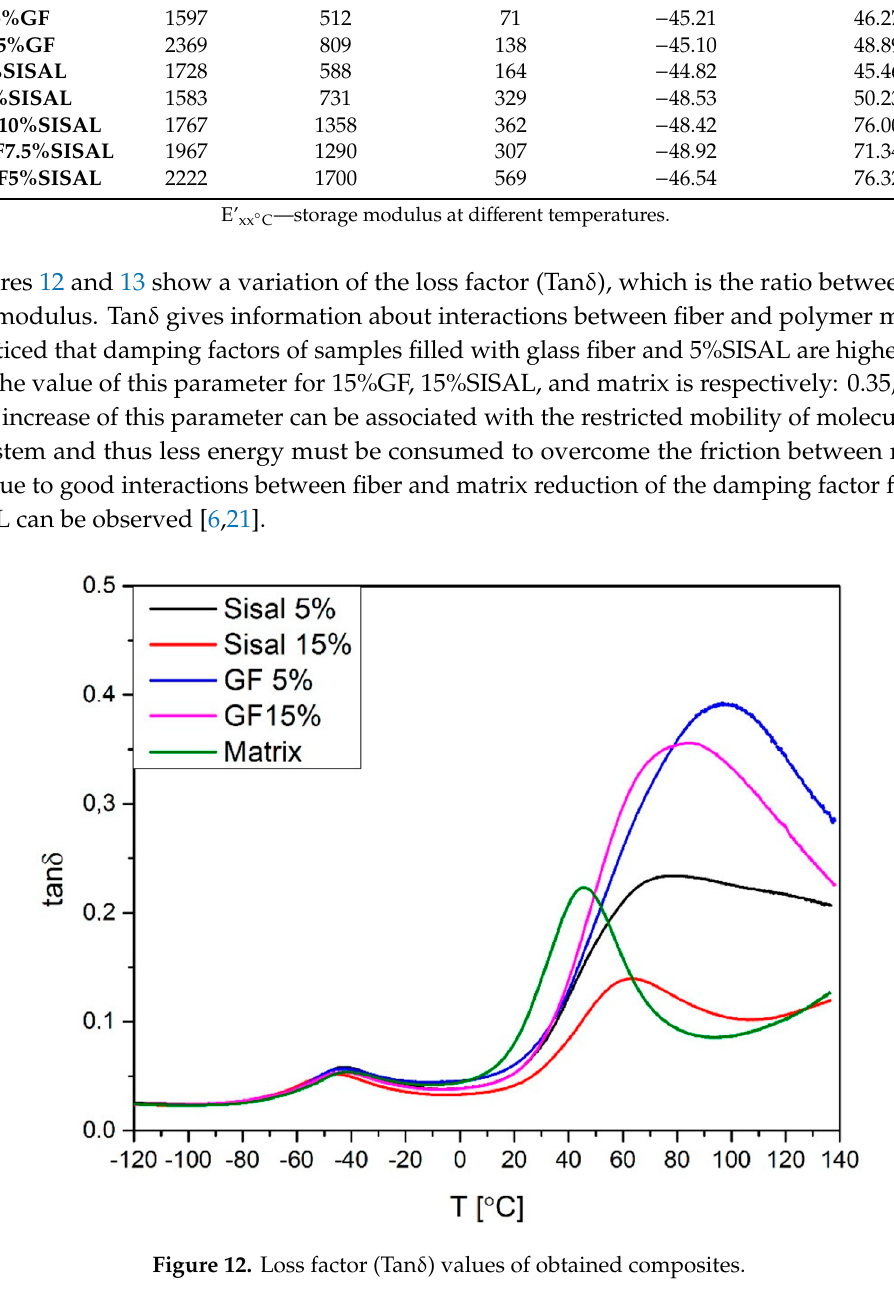
Figure 13. Tan δ values of obtained hybrids. Sisal and glass fiber micrographs are shown in Figures 14 and 15. In Figure 14 we can observe that short cells are joined together along the sisal fiber. Moreover, the surface roughness of the sisal fiber can be noticed. The presence of these cells and high roughness increases the fiber surface, which can increase the interaction surface and the fiber's adhesion to the matrix. Holes inside the sisal fiber can be noticed. Figure 15 shows compact glass fiber packs. Due to absence of characteristic functional